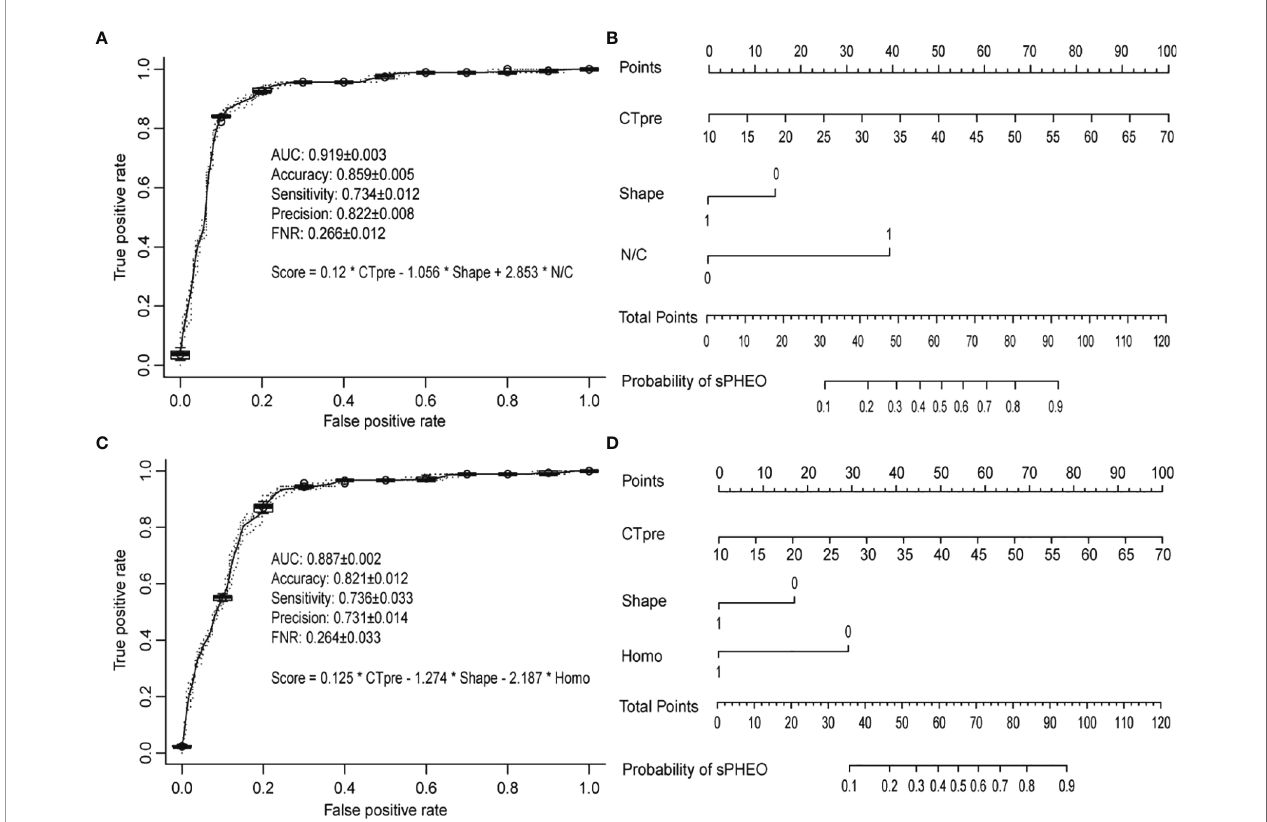
FIGURE 3 | The receiver operating characteristic (ROC) curves and nomograms for the models based on the CT imaging features. The ROC curves were based on predictions from the validation data in fi ve times of cross-validations, while the nomograms were drawn based on predictions from all data used for deriving the model. The average and standard deviation of the predictive performance measures in fi ve times of cross-validations were shown. (A, B) refer to model M1 with features of “ CT pre + Shape + Necrosis or Cystic (N/C) ” ; (C, D) refer to model M2 with features of “ CT pre + Shape + Homogeneity (Homo) ” .